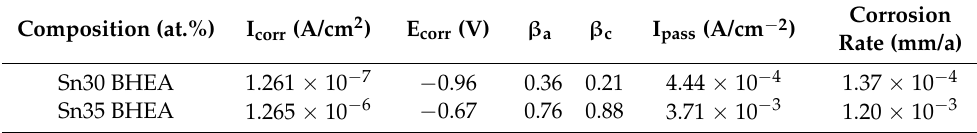
Table 4. The key electrochemical parameters of Sn30 BHEA and Sn35 BHEA. Composition